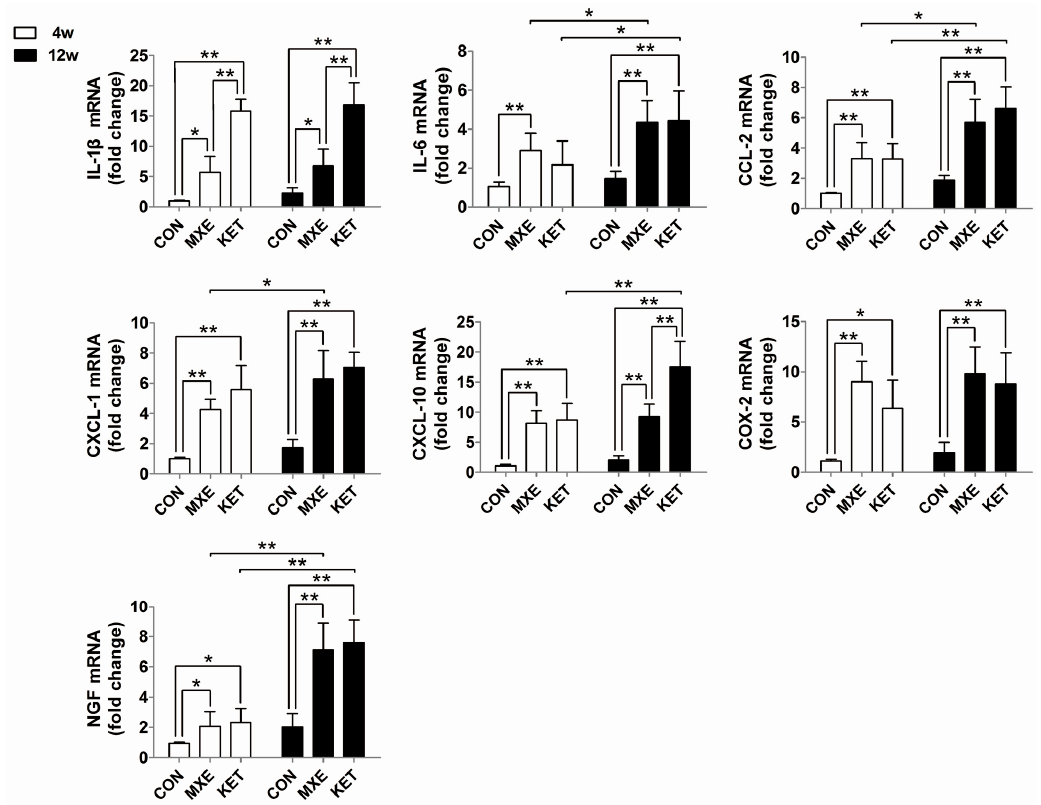
Figure 6. Relative levels of cytokine/chemokine gene expression of rats. The qRT-PCR analysis results for IL-1 β , IL-6, CCL-2, CXCL-1, CXCL-10, COX-2, and NGF in bladder tissue of normal saline, methoxetamine and ketamine treated rats ( n = 6 in each group). Data are expressed in mean ± SD, as the fold-change vs. the mean value in the control group at four weeks. Two-way ANOVA were used for analysis. * p < 0.05, ** p < 0.01.